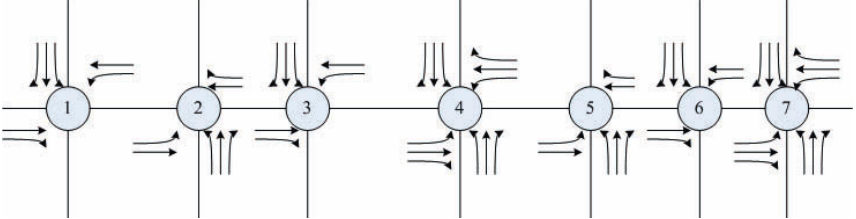
Figure 4. Road network for numerical tests.